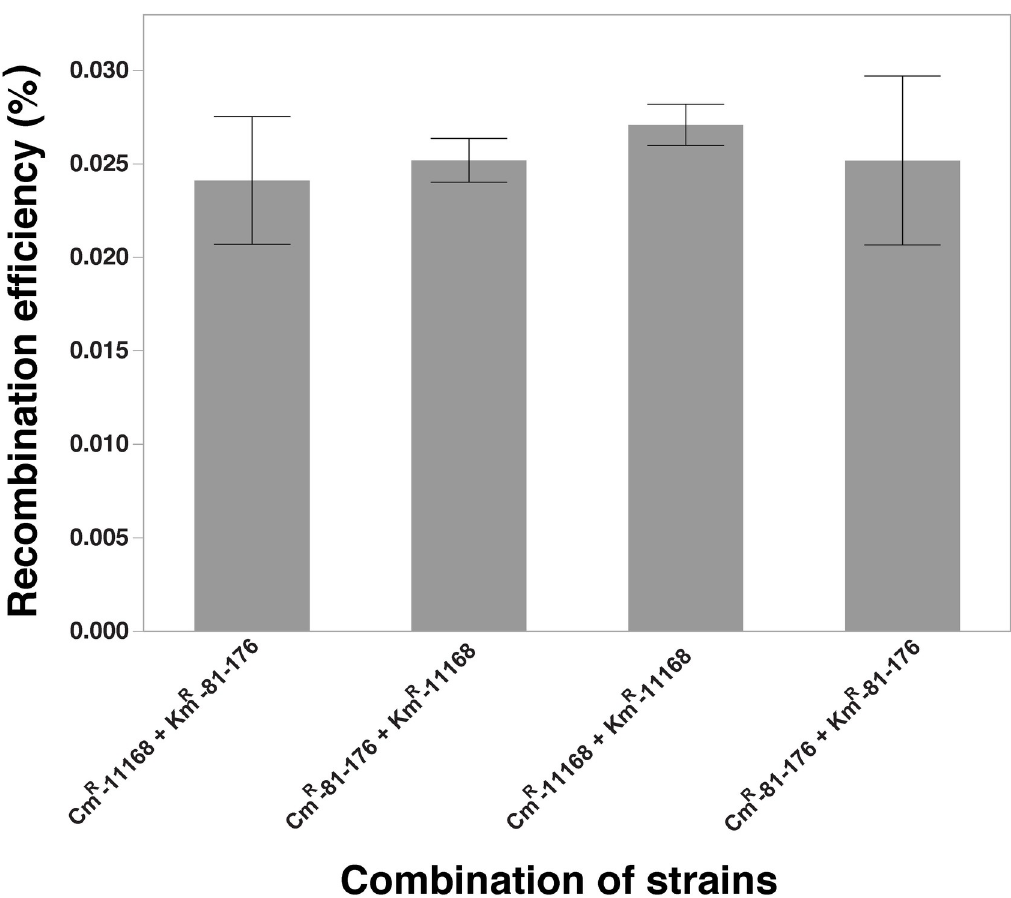
Fig 7. Comparison of the recombinant levels when the different combinations of the marker strains were used. Two different strain backgrounds (C . jejuni strain 11168 and strain 81–176) were used for different combinations of marker strains; Recombinant levels expressed as percentage recombinants in the total number of parent cells; No significant difference was found across different combinations at P < 0.05.